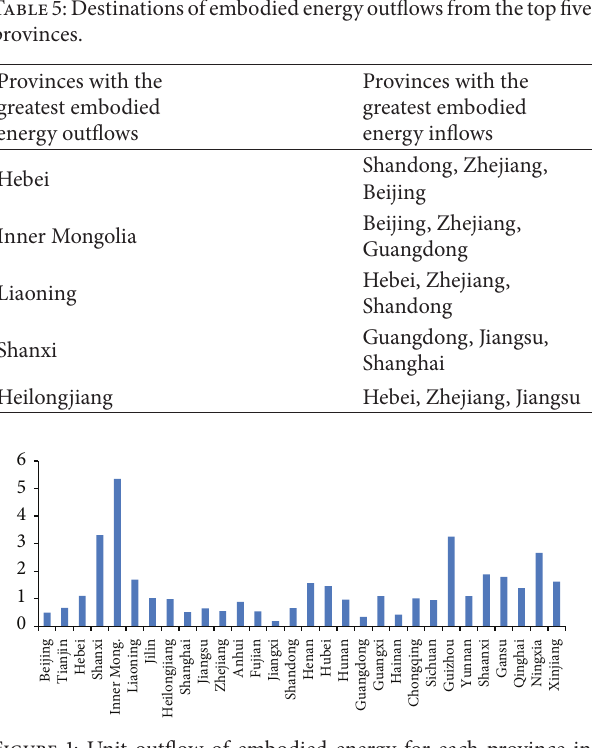
Figure 1: Unit outflow of embodied energy for each province in 2007 (in tons of standard coal/10,000